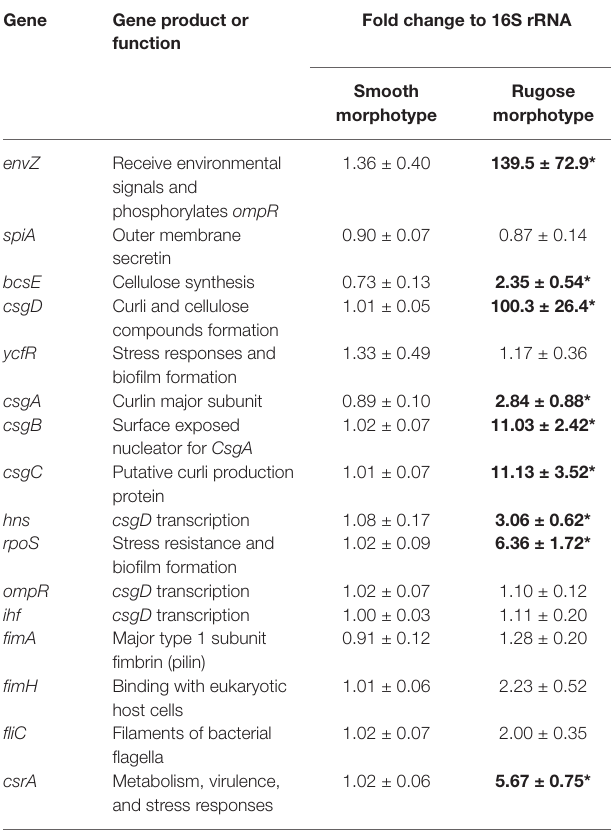
TABLE 2 | Fold change in the expression of S . Typhimurium ATCC 14028 biofilm and multicellular behavior associated genes. Gene Gene product or function